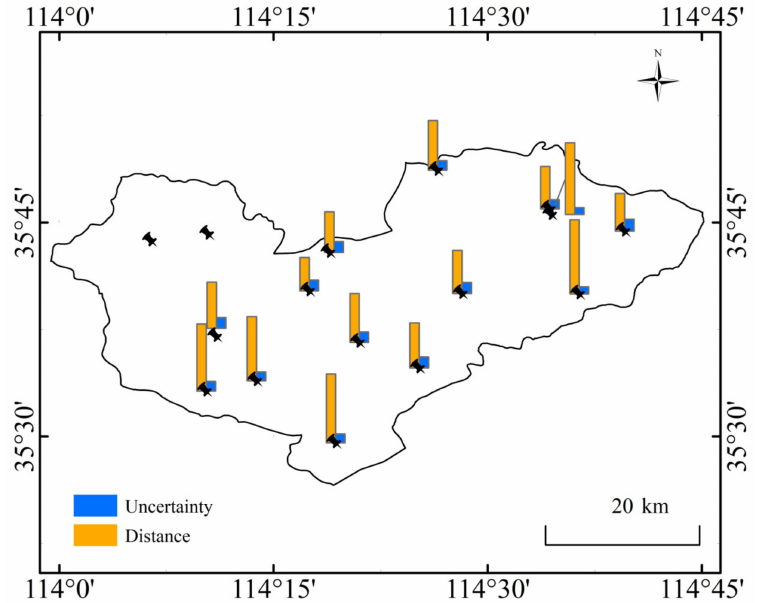
Figure 5. The histogram of mean Manhattan distance and mean uncertainty at each site.